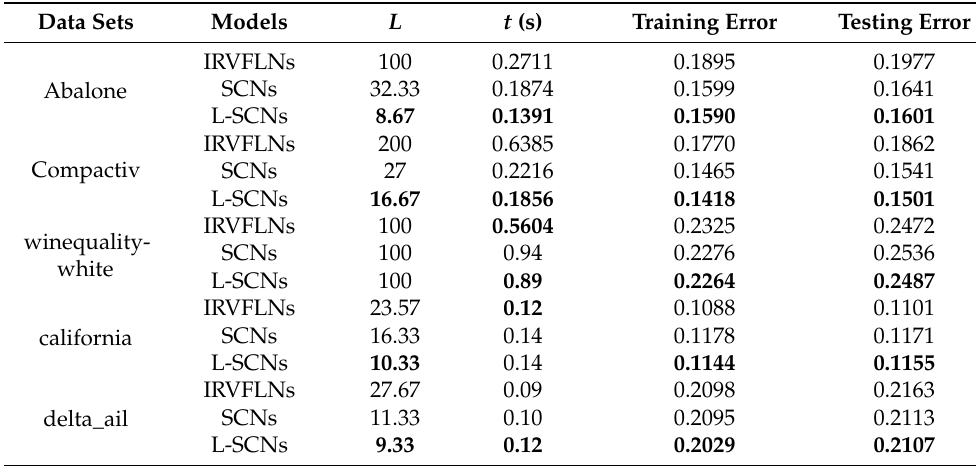
Table 4. Performance comparison for regression data